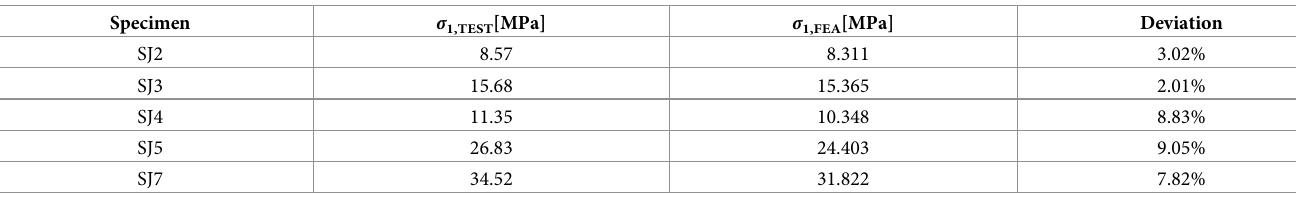
Table 4. Maximum stress on surface D-2 of simulation and test